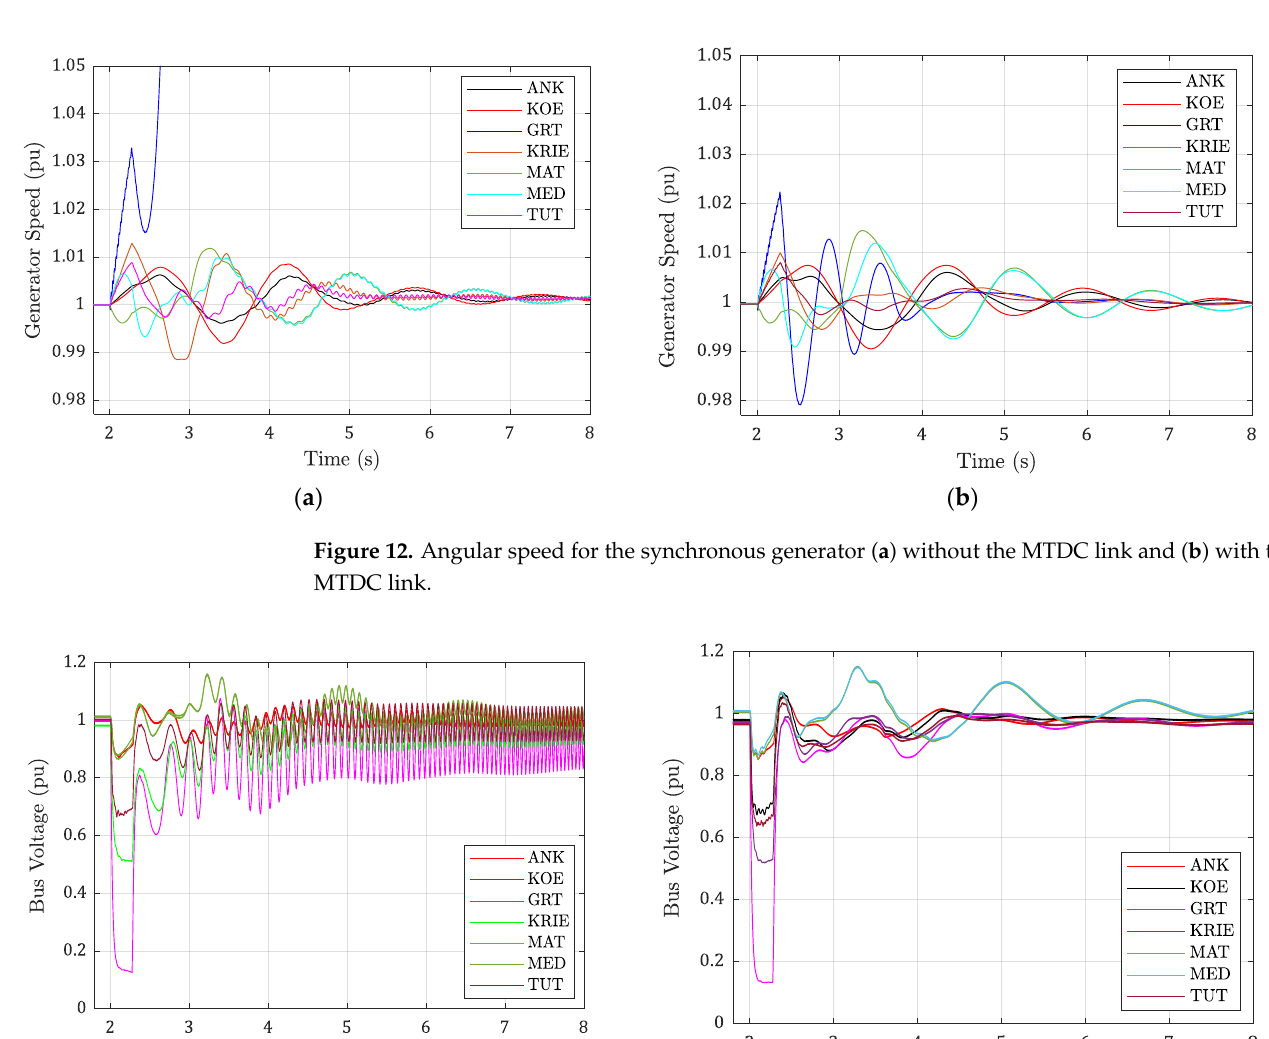
Figure 11. Rotor angle for the synchronous generator ( a ) without the MTDC link and ( b ) with the MTDC link.